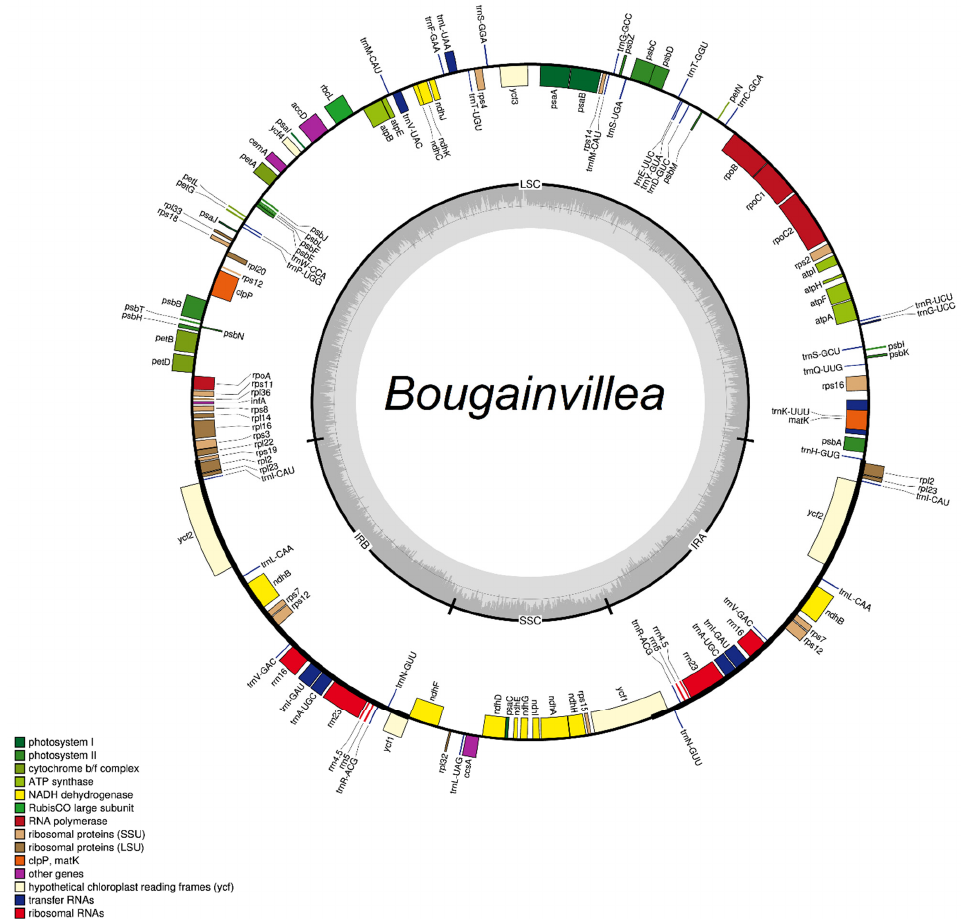
Figure 1. General circular gene map of Bougainvillea chloroplast genomes showing the large single- copy (LSC) region, small single-copy (SSC) region, and inverted repeat regions (IRA, IRB). Genes within the circle were also color-coded according to their functional group. The dark gray and light gray plots correspond to the GC and AT contents, respectively. The SNPs (single nucleotide polymorphisms) and indels (insertions-deletions) were identified in the plastid genomes of Bougainvillea using MUMmer4 [19] and Geneious Prime 2020.1 [20]. The overall results indicated that there were more SNPs and indels in the chloroplast genomes of B. pachyphylla , B. peruviana , and B. modesta . This can be